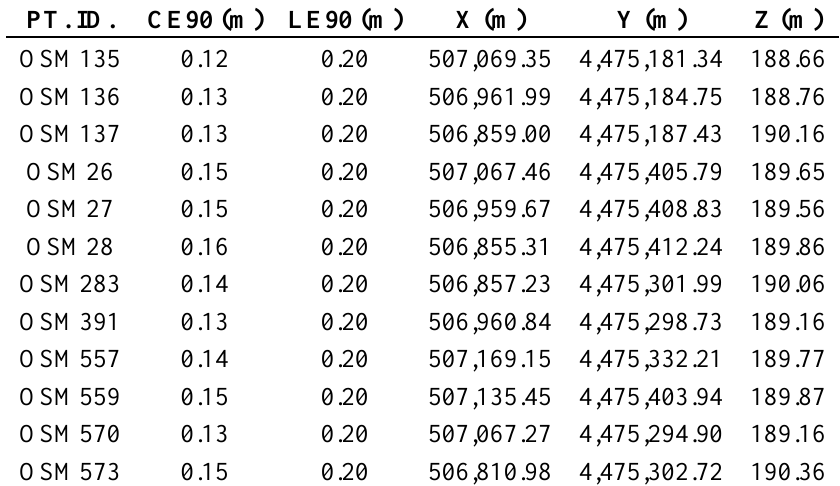
Table 1. Adjusted shape point